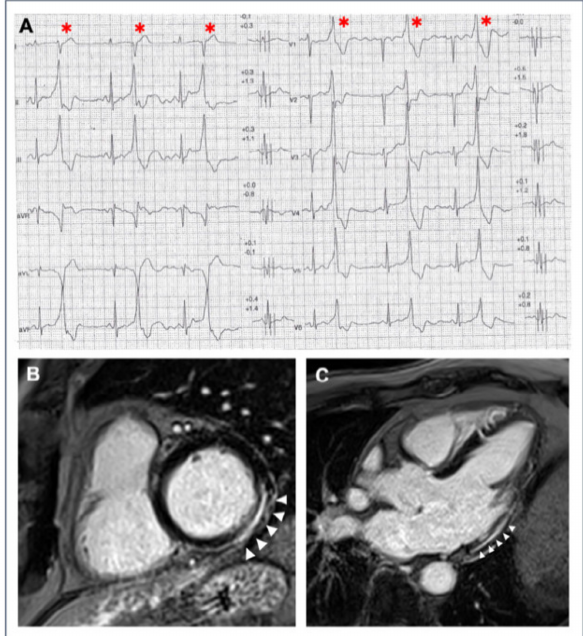
Figure 1. A 40-year-old athlete presented with frequent PVBs on ECG ambulatory monitor- ing. Exercise test revealed frequent and repetitive monomorphic PVBs with RBBB/inferior axis morphology (( A ), red asterisks). Post-contrast sequences on CMR showed an LGE subepicar- dial/midmyocardial stria in the basal inferolateral and inferior LV walls (white triangles; ( B ) short-axis view; ( C ) 3-chamber view).